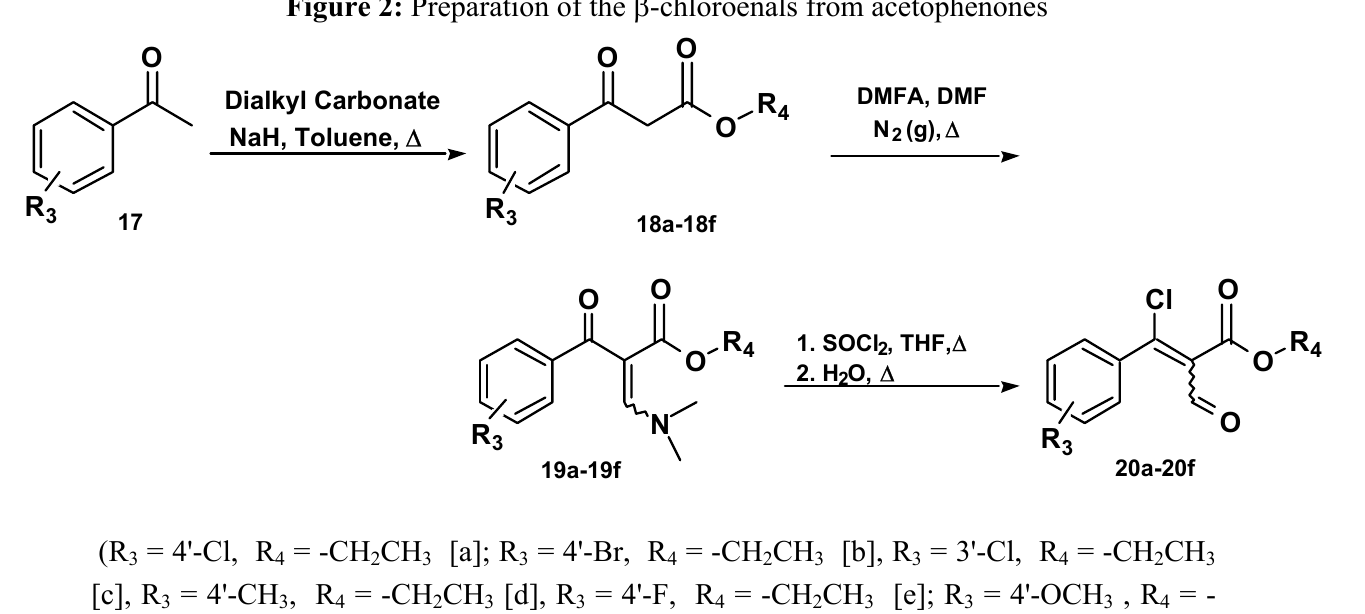
Figure 2: Preparation of the β -chloroenals from acetophenones